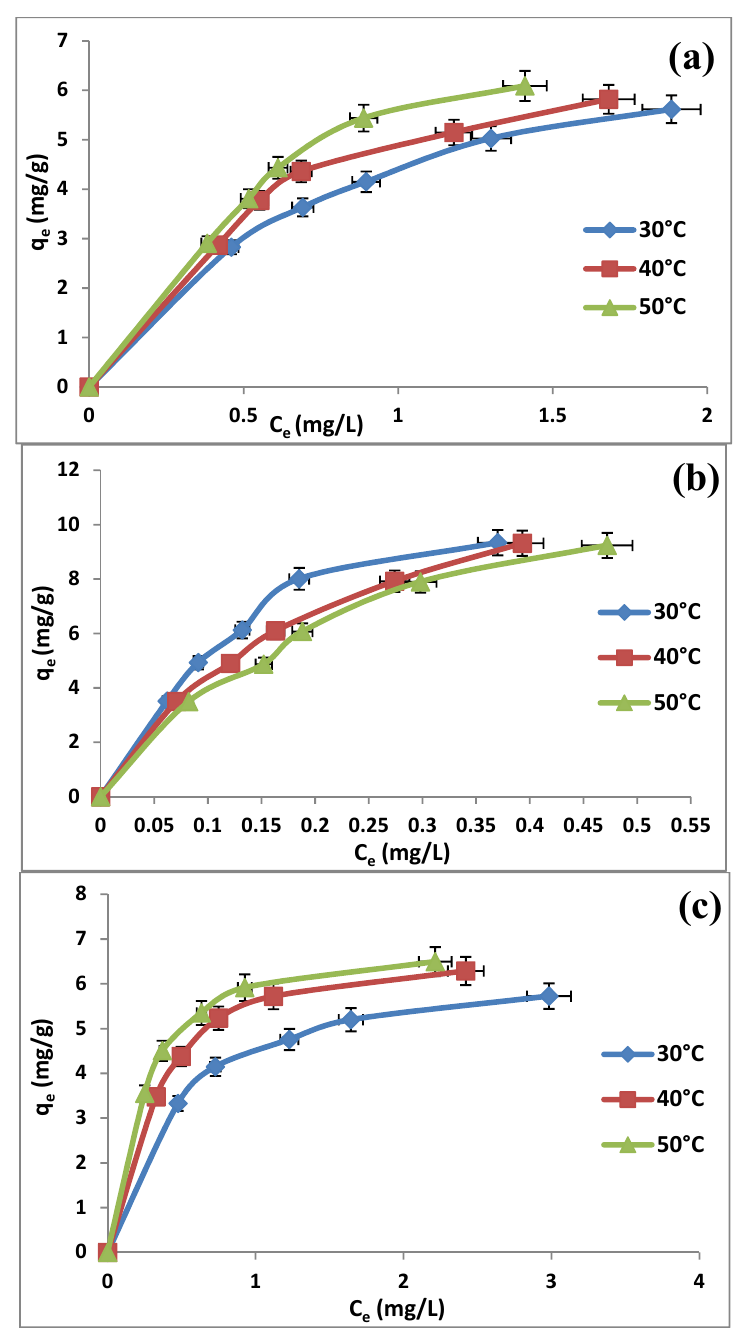
Figure 7. Adsorption isotherm for TBT on MCM-TDI-C4 ( a ), MCM-TDI-PC4 ( b ) and MCM-TDI-C4S ( c ) at different